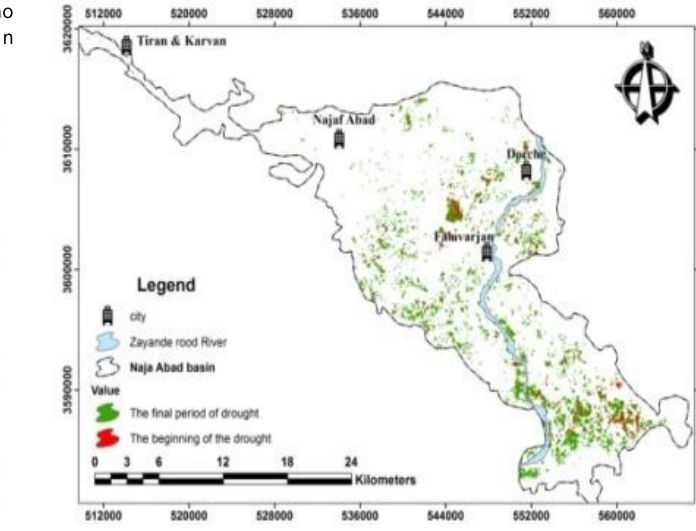
Figure 7. Zoning of drought condition pixels